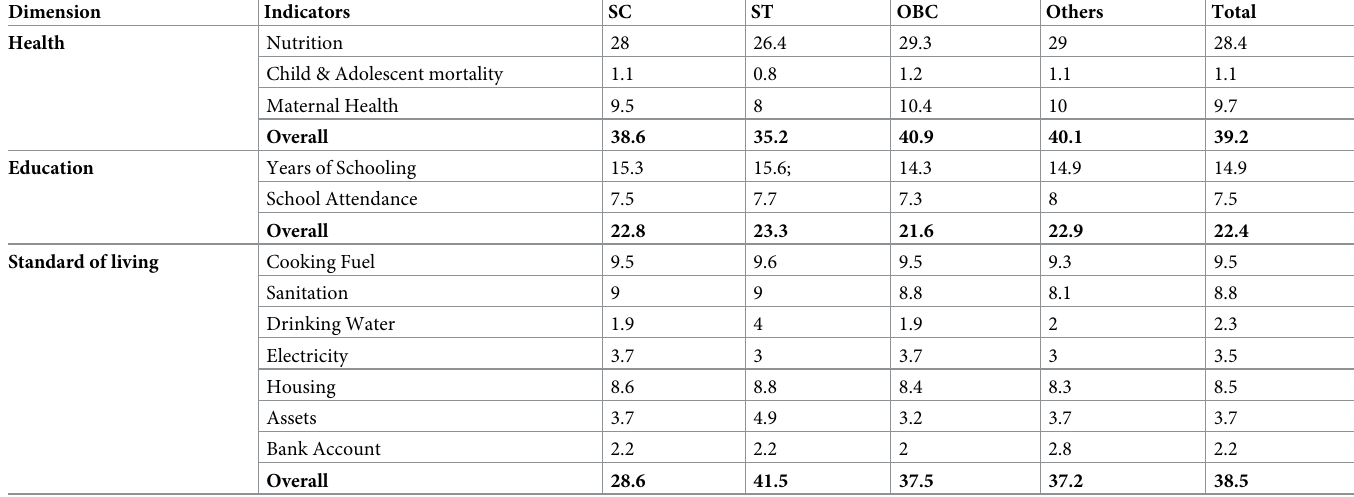
Table 5. Contribution of each indicator to multidimensional poverty index across social groups.